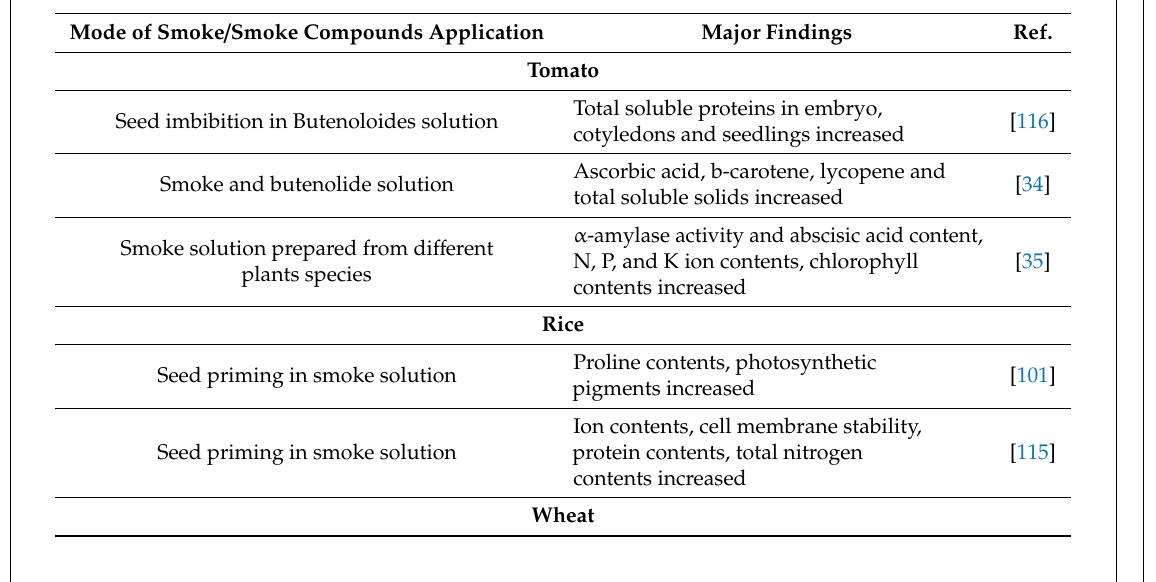
Table 3. E ff ect of plant-derived smoke on physiological responses of various